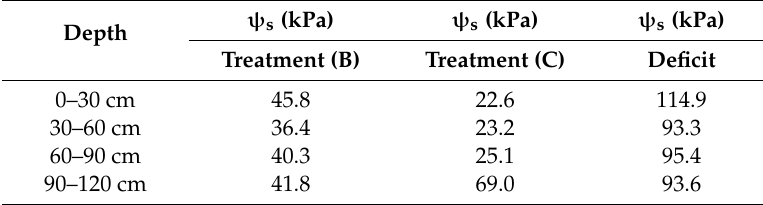
Table 7. Average soil matric potential ( ψ s ) within the 120 cm soil depth (average daily values) (kPa) on 28 June, toward the end of the growing